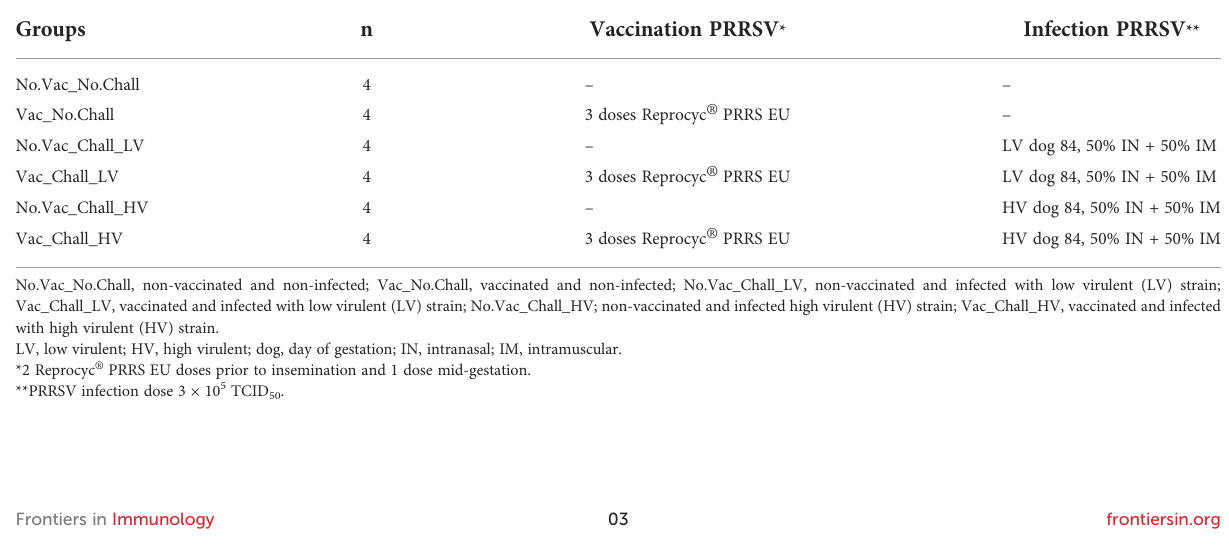
TABLE 1 Overview six treatment